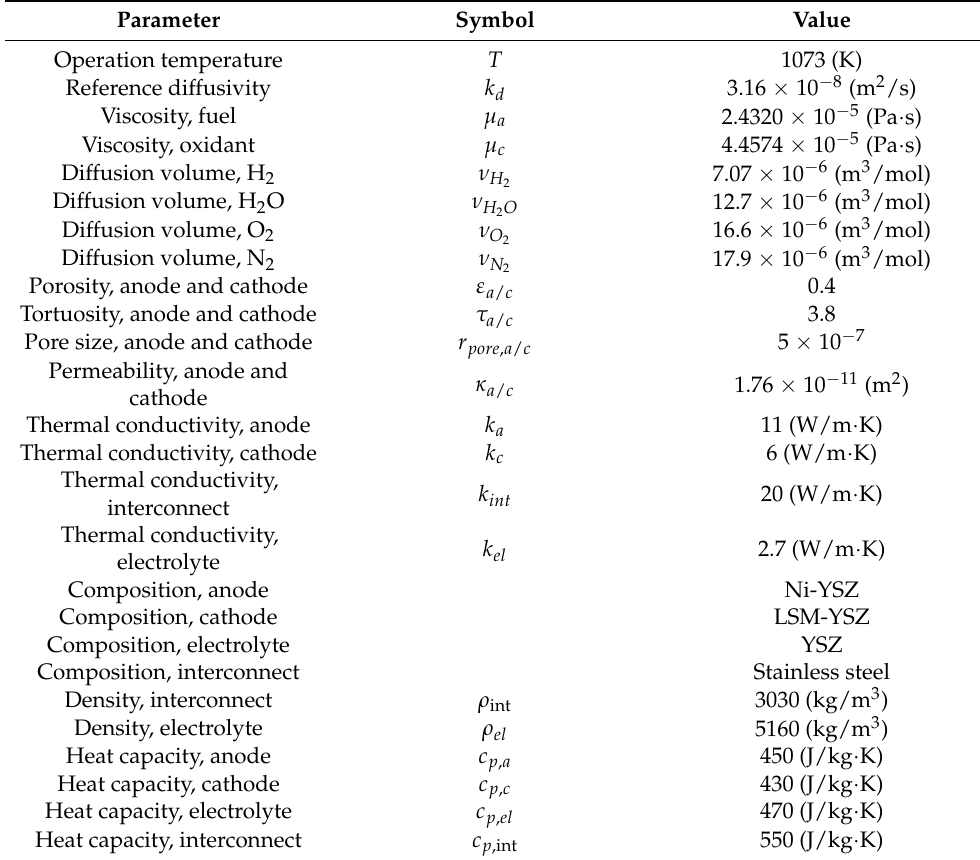
Table 3. Operation condition, thermal conductivities, densities, and heat